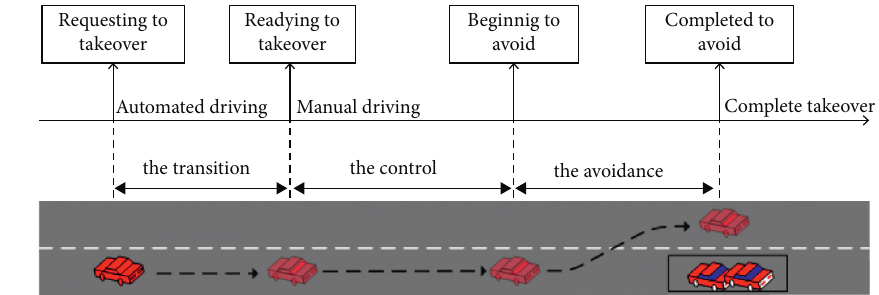
Figure 2: Three stages of